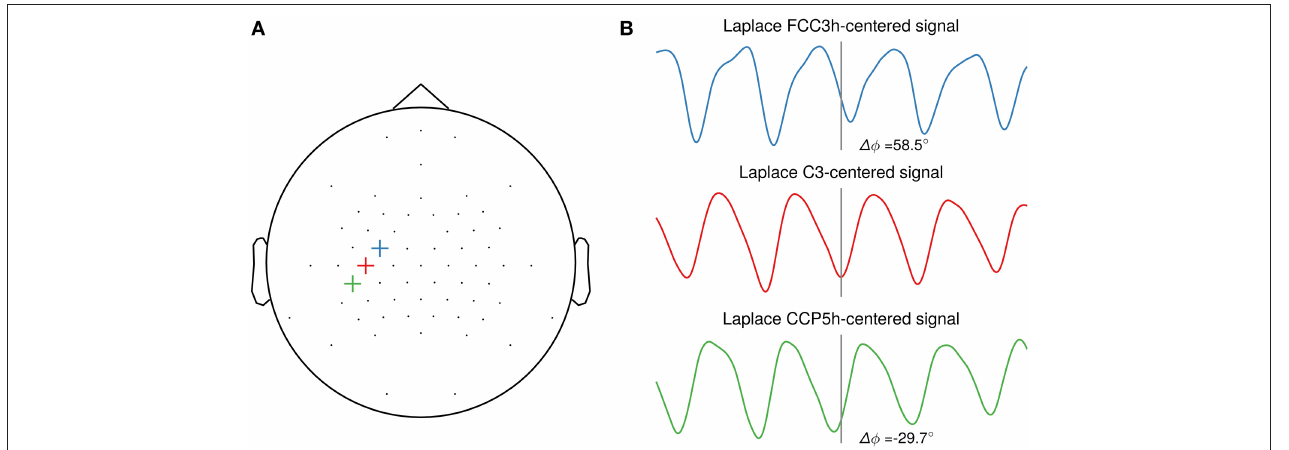
FIGURE 2 | Illustration of phase shifts in sensor space . (A) Topography with three neighboring channels (FCC3h, C3, CCP5h) selected as center electrodes for the local spatial filter. (B) Resting-state EEG sensor space signals of one participant spatially filtered by a Laplacian filter centered on the selected electrode. The events are aligned to the troughs of the C3-centered Laplacian signal. A systematic phase shift is visible in the FCC3h- and CCP5h-centered signal respective to the C3-centered Laplacian signal troughs, with 58.5 ◦ and − 29.7 ◦ , respectively.